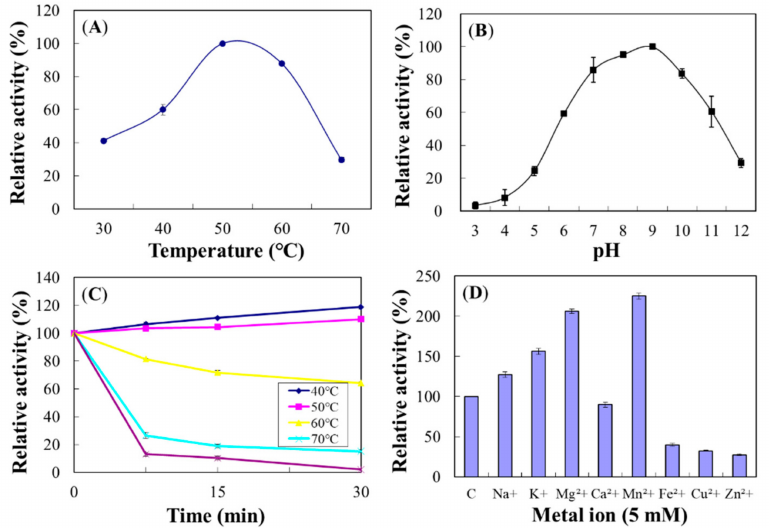
Figure 12. Effects of temperature ( A ), pH ( B ), thermostability ( C ), and metal ions ( D ) on the enzyme activity of Chi19B. The properties were characterized using the DNS method with colloidal chitin as a